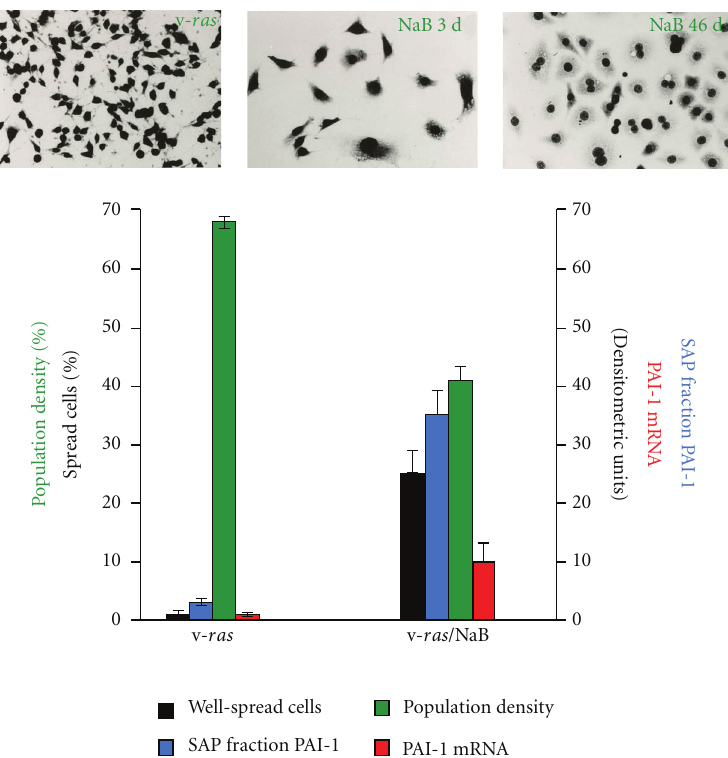
Figure 4: Summary characteristics of the NaB-induced phenotype in v- ras -transformed renal epithelial cells. NaB initiated a rapid cytostasis evident within 3 days after exposure with the acquisition of increased cell-spread area consistent with FALS assessment of cell size (i.e., Figure 2). Cells remained growth arrested even after protracted treatment (e.g., 46 days) although such long-term cultures had an increased binucleate frequency. PAI-1 mRNA/protein expression in control populations was low to undetectable in contrast to the levels of PAI-1 transcripts and protein evident in response to NaB. Plots illustrate the mean ± standard deviation for triplicate assessments for each of the parameters evaluated.